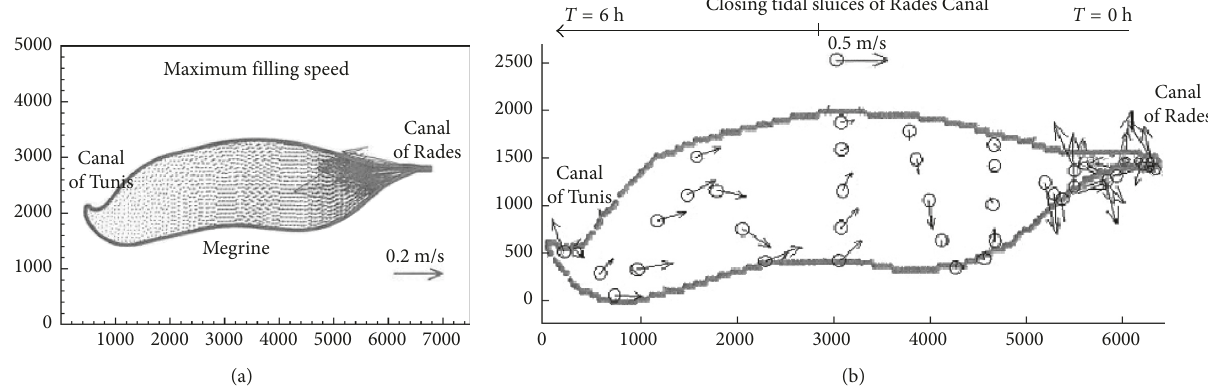
Figure 2: Water circulation in the South Lagoon of Tunis: (a) filling speed of the lagoon [25] and (b) the direction of water circulation on the lagoon